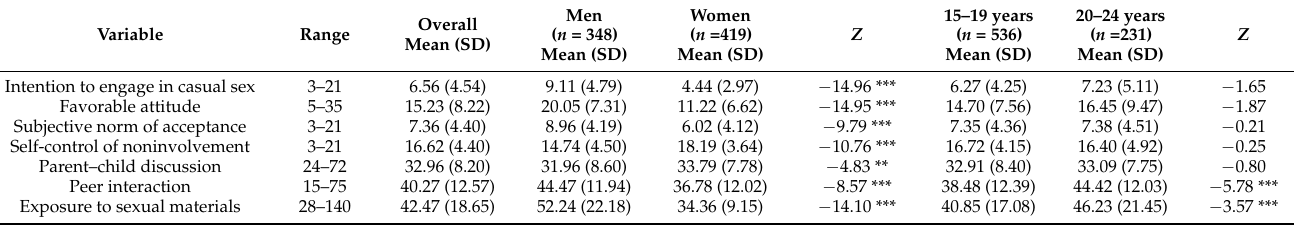
Table 1. Comparisons of intention, three TPB constructs, parent–child discussion, peer interaction, and exposure to sexually explicit materials between men and women and between participants aged 15–19 and 20–24: Mann–Whitney U test ( n = 767). Variable